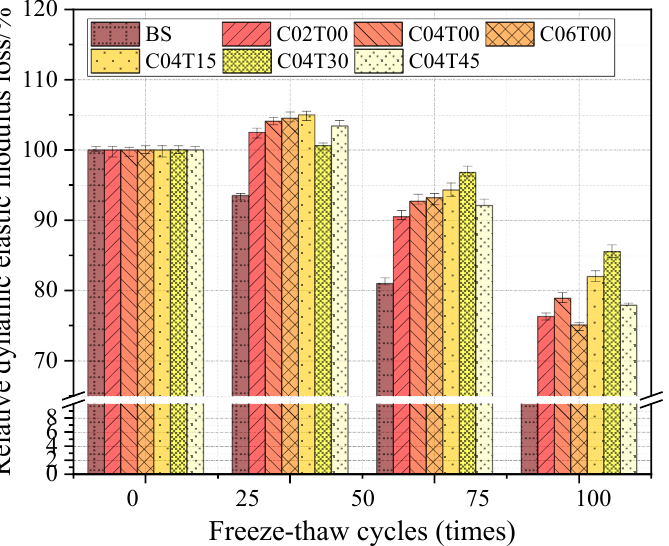
Figure 6. Relative dynamic elastic modulus of cement-based composites under freeze-thaw cycles.